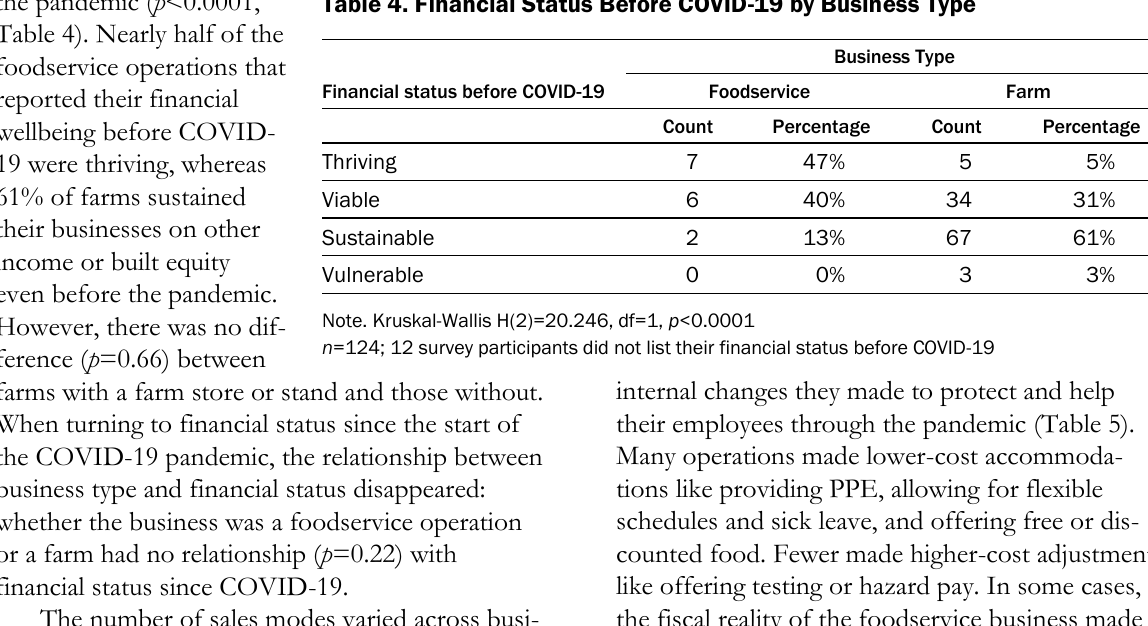
Table 4. Financial Status Before COVID-19 by Business